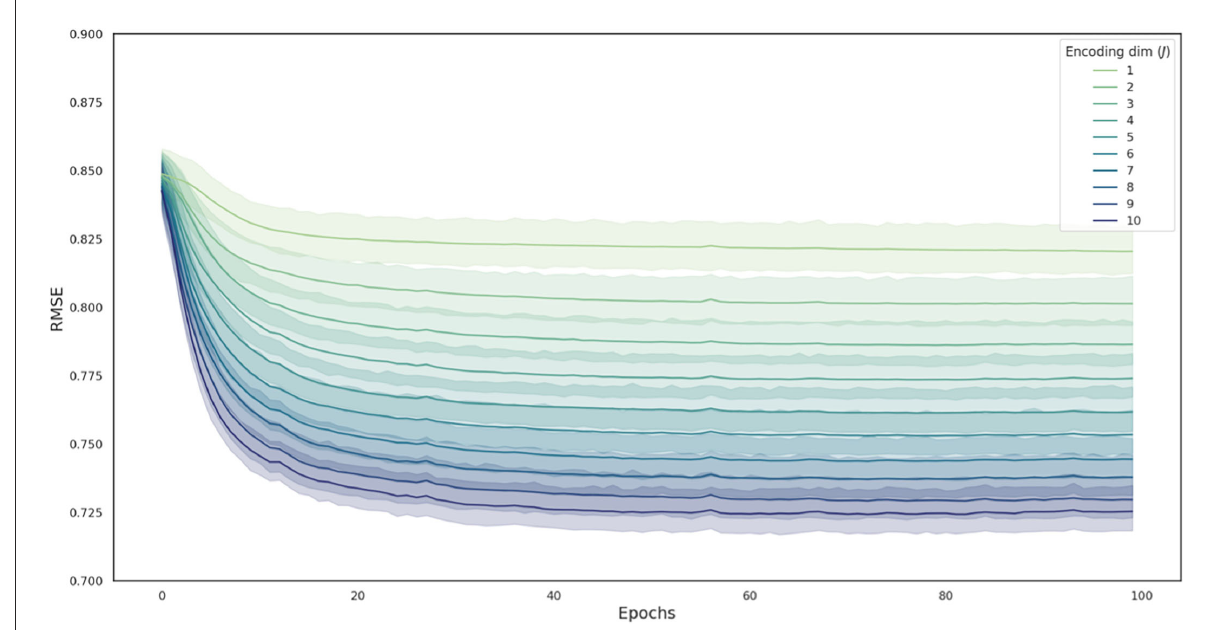
FIGURE3 The change in RMSE during the model training process in each deep autoencoder architecture. Curves are averaged over 10 folds, with the shaded area representing the 95% confidence interval across folds. RMSE, root mean squared error.